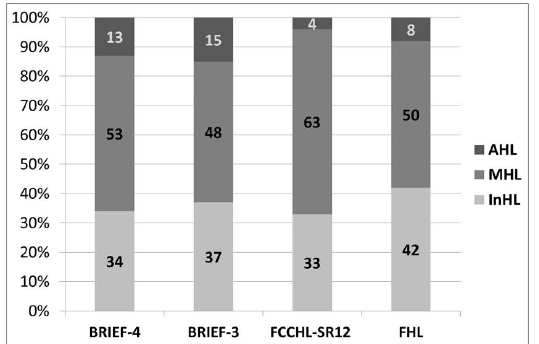
Figure 1. Distribution of HL levels among instruments. AHL—adequate health literacy, MHL—marginal health literacy, InHL—inadequate health literacy.